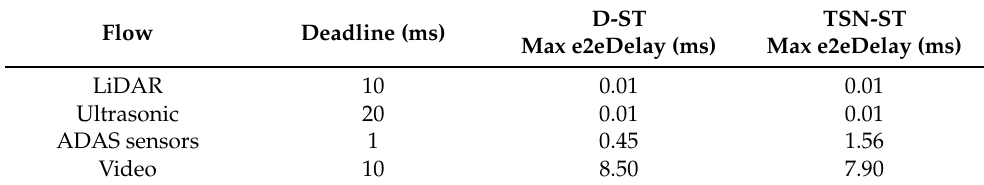
Table 3. Simulation results: maximum end-to-end delay. Flow Deadline